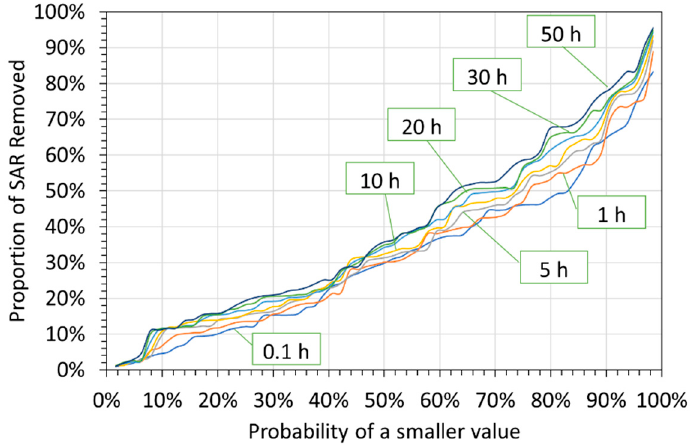
Figure 17. Proportion of SAR removed versus probability of a smaller value, for [c] = 0.1 h, 1 h, 5 h, 10 h, 20 h, 30 h and 50 h. Assumptions: initial Ca = 10.3 meq L − 1 ; initial Mg = 52.8 meq L − 1 . Table 2. Example flowback water compositions from shale gas wells in Australia (Northern Territory (Wells 1 and 2)) and USA (Marcellus Shale (Wells 3 to 11). All measurements are in g L − 1